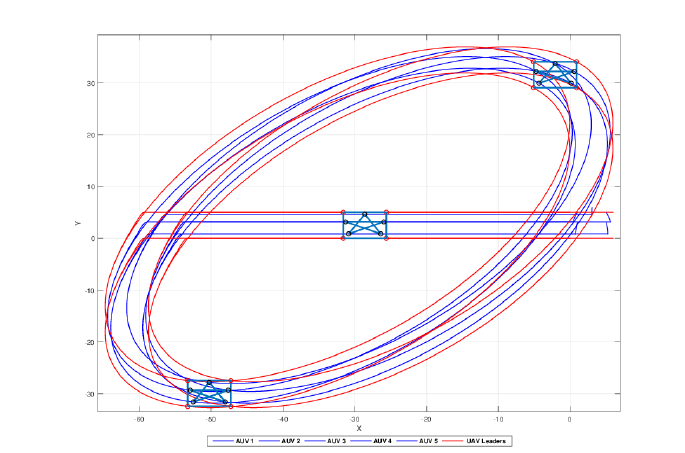
Figure 11. The containment control of five AUVs in star formation with their four UAVs leaders in square formation under disturbance and uncertainty in 2D space.